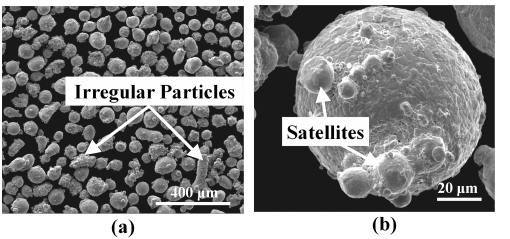
Figure 1. ( a ) SEM image of the virgin IN718 powder. ( b ) A high-magnification SEM image showing one of the larger particles with satellites attached to it.